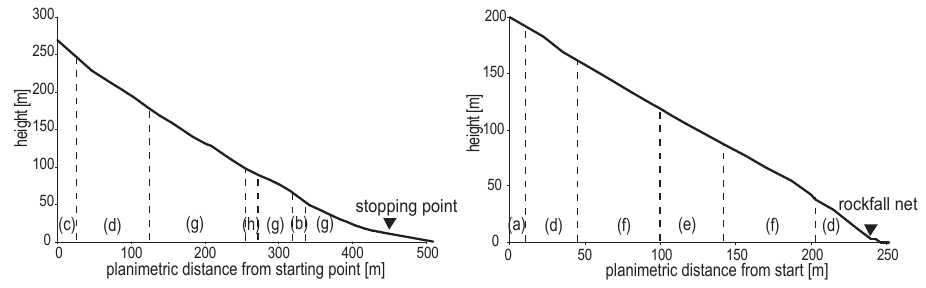
Fig. 2. Slope profiles in Steg (left) and Bad Ischl (right). The lowercase characters denote the surface types presented in Table 2.